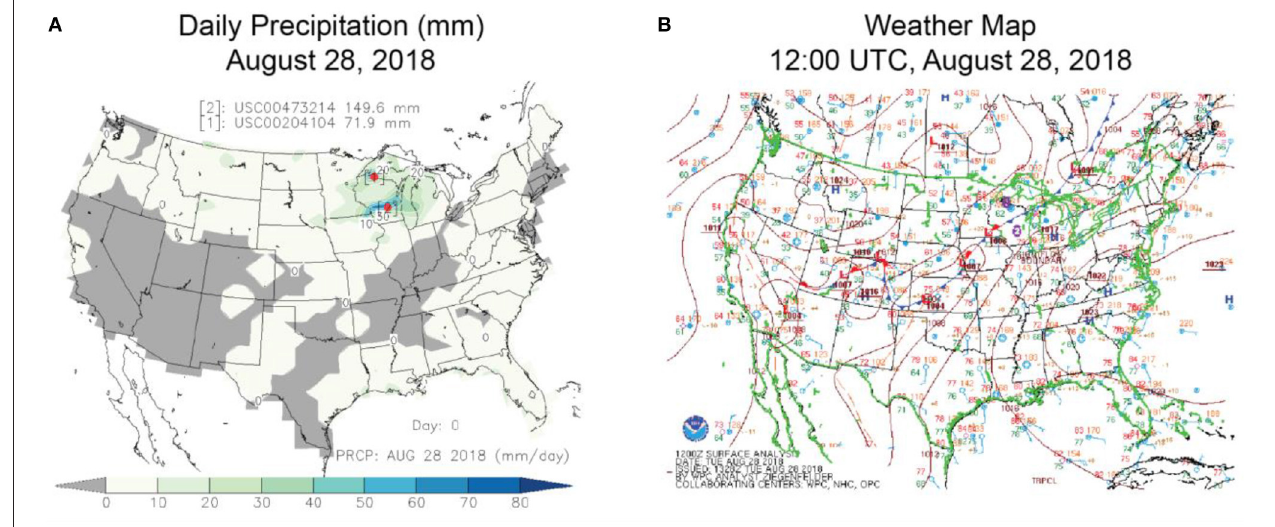
FIGURE 2 | Weather maps including (A) map of daily precipitation (mm) and (B) map of weather features, for a day (August 28, 2018) with two extreme events caused by a front (ETC-FRT). The red dots in (A) and the white-on-purple numbers in (B) indicate the locations of the two